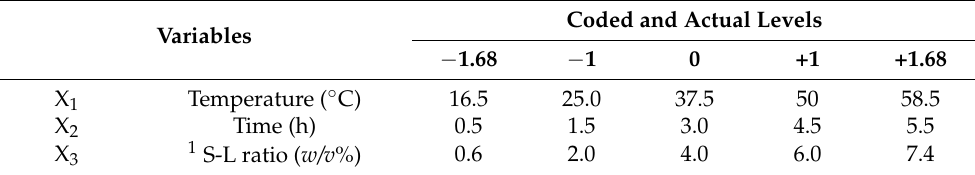
Table 3. Experimental ranges and coded levels of independent variables for central composite design.